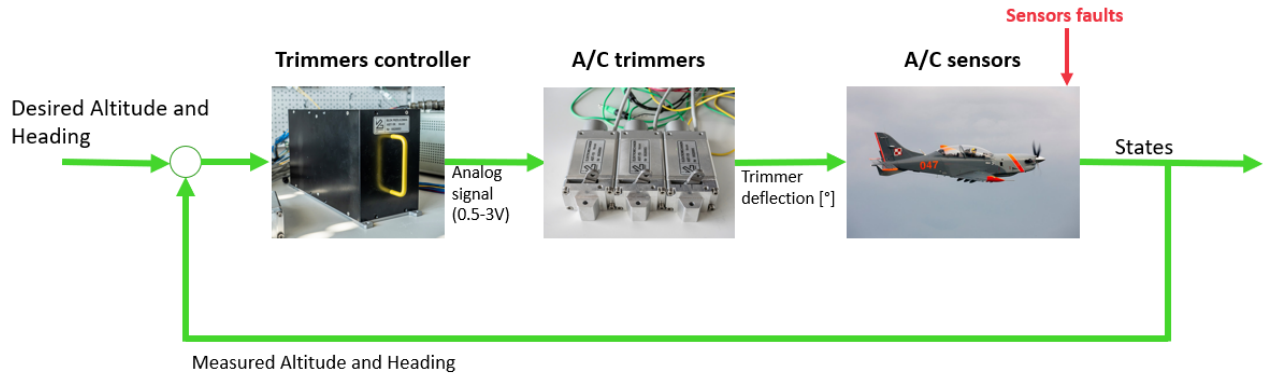
Figure 1. General structure of the TSS system.